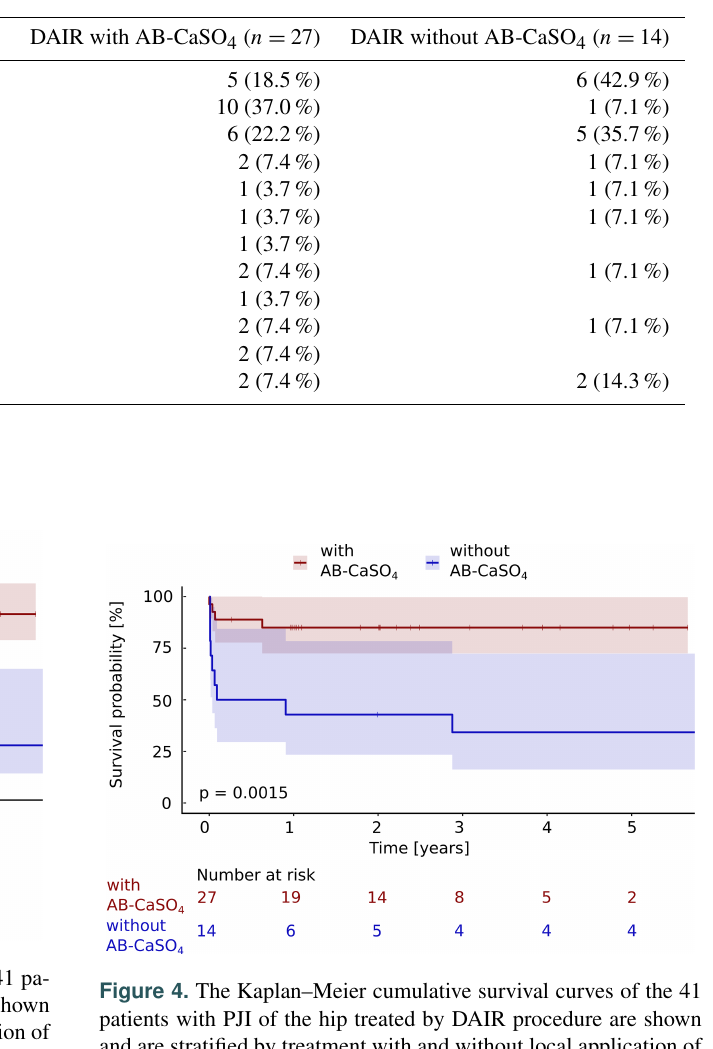
Table 2. Overview of the microorganisms identified in our study population. There were no statistically significant differences between the groups. The identification procedure for microorganisms changed during the study period. Until December 2017, only a phenotypical identification was performed. Since January 2018, matrix-assisted laser desorption/ionization time-of-flight (MALDI-TOF) spectrometry has allowed the identification of individual species. As more than one microorganism may be identified in a patient’s samples, the total numbers do not add up. In total, four cases had a polymicrobial infection, i.e., two in each treatment group. Any identified microorganism had to fulfill the usual diagnostic criteria to be considered as causative (Zimmerli et al., 2004; Osmon et al., 2013). In two cases, culture-negative infections were treated. In both cases, clinical and radiological signs were present, indicating an overt infection. However, in these cases, antibiotic treatment had been started before sampling in a referring institution.